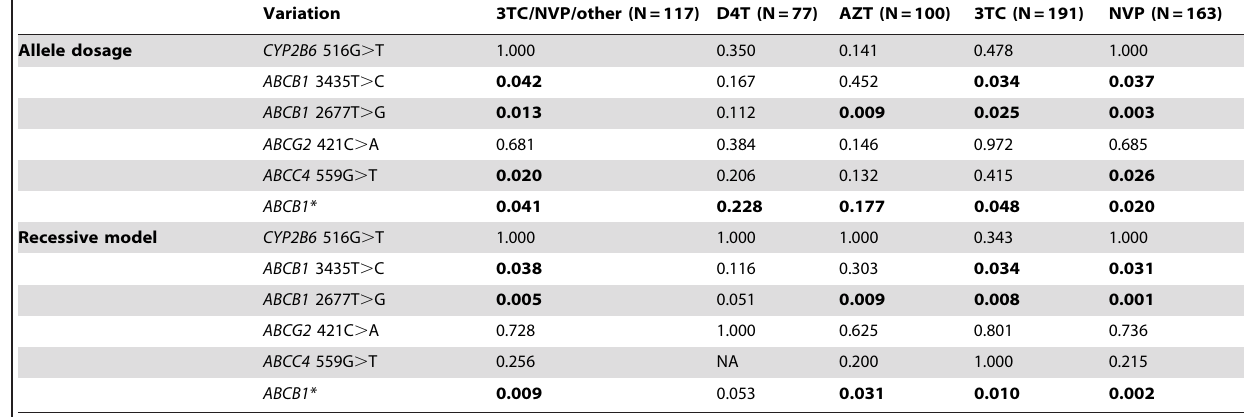
Table 6. Association analysis of SNPs and therapeutic